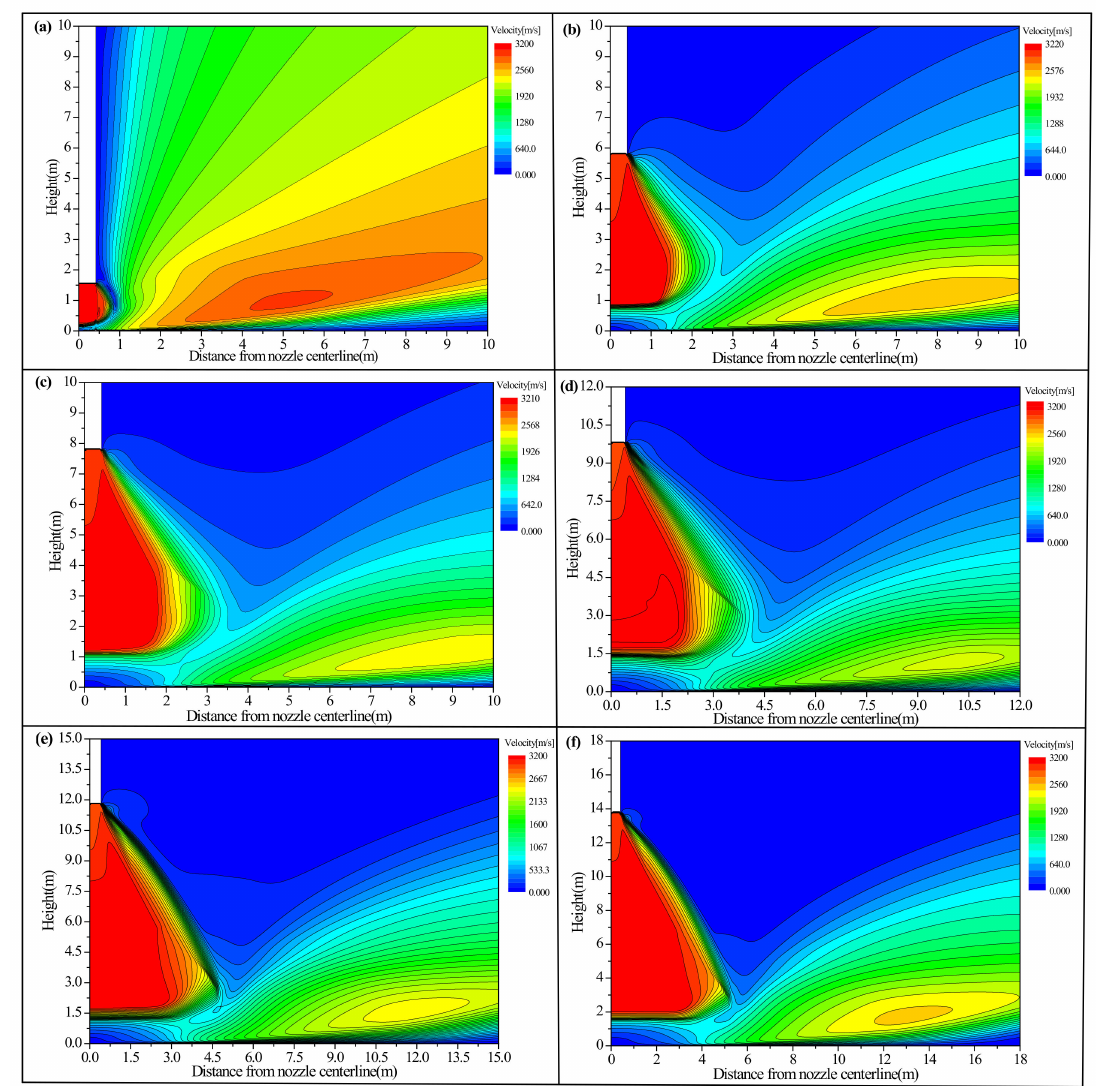
Figure 5. The velocity contours at different nozzle altitudes: ( a ) h = 1.54 m, ( b ) h = 5.80 m, ( c ) h = 7.83 m, ( d ) h = 9.82 m, ( e ) h = 11.83 m, and ( f ) h = 13.74